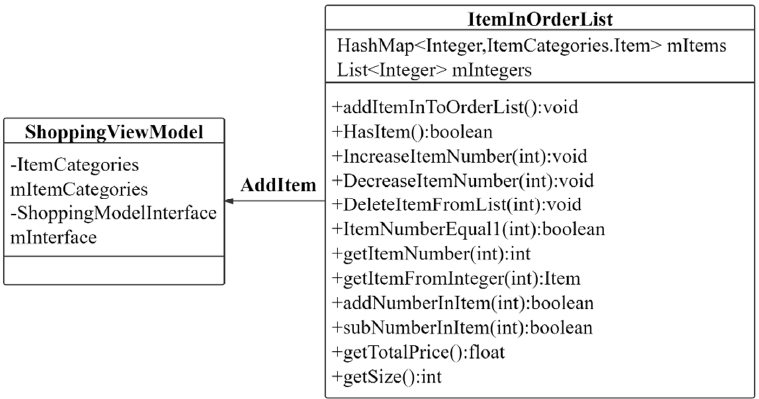
Figure 22. Generate product order information class.